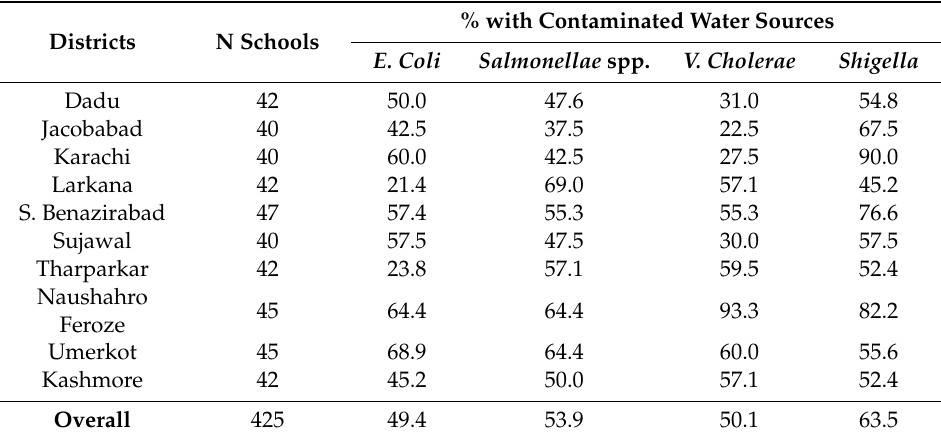
Table 3. Frequency of microbial